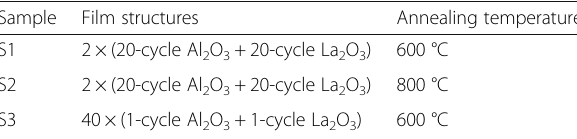
Table 1 The structures and annealing temperatures